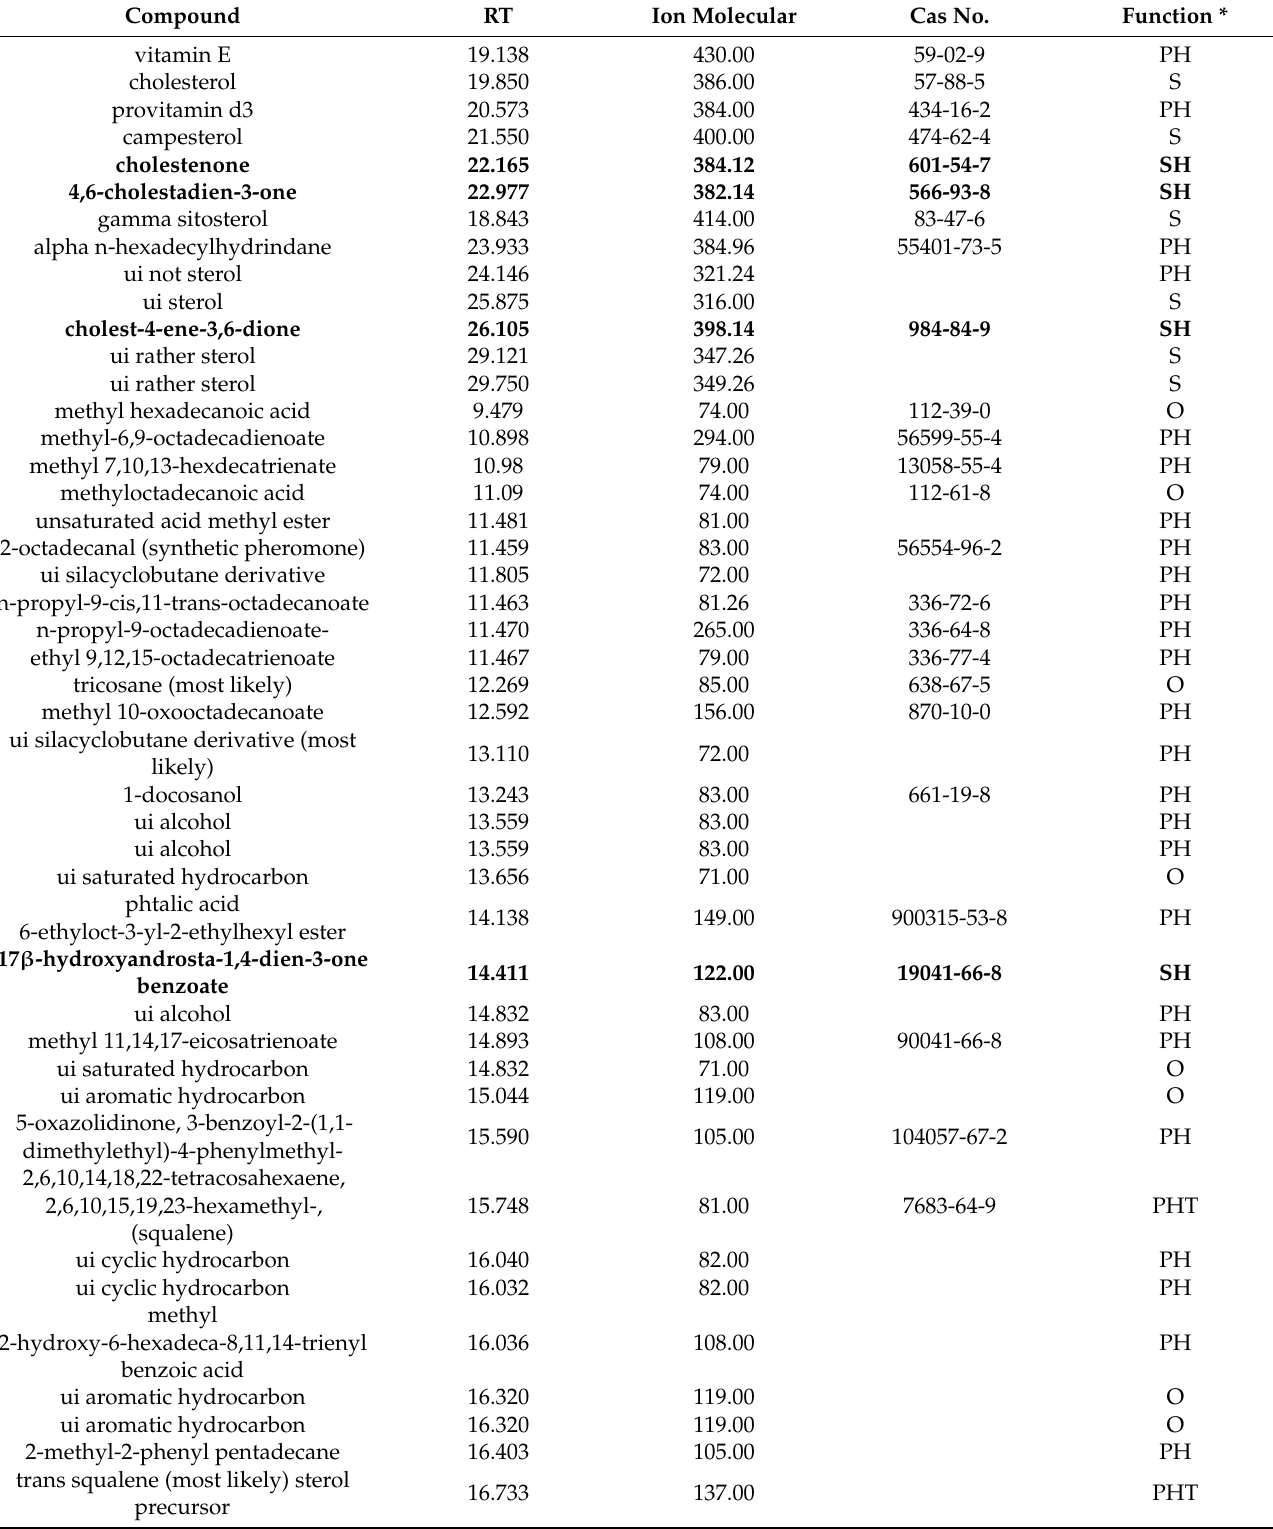
Table 2. List of sex-differentiating substances isolated from the adult bodies of I. typographus and P. chalcographus , originating from Theysohn pheromone traps and specifying their function * (PH = probable pheromone, S = sterol, H = probable hormone, O = indifferent (i.e., neither pheromone, either hormone), T = terpene and UI = unidentified). Substances that are potential steroid hormones are marked in